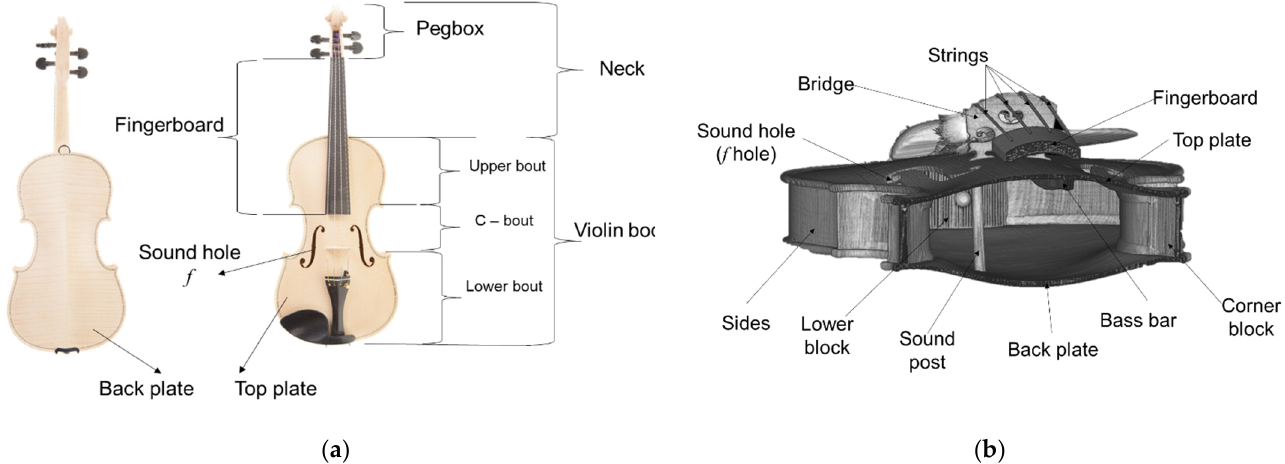
Figure 1. The constructive elements of the violin: ( a ) the front view of the violin; ( b ) cross section through the violin.